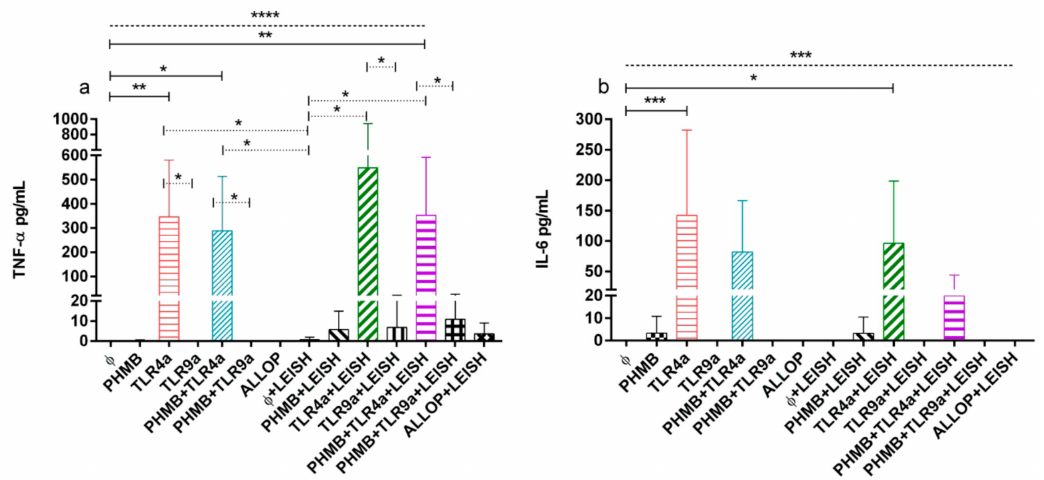
Figure 4. ( a ) TNF- α and ( b ) IL-6 concentrations from uninfected and infected macrophages treated with the following conditions. Medium alone (Ø), Polyhexamethylene biguanide alone (PHMB), MPLA Toll-like receptor agonist 4 (TLR4a), PHMB plus TLR4a (PHMB + TLR4a), CpG ODN Toll-like receptor agonist 9 (TLR9a), PHMB plus TLR9a (PHMB + TLR9a), and allopurinol (ALLOP). All the conditions indicated with LEISH are L. infantum infected replicates. Significant results are described as * 0.05 > p > 0.01, ** 0.01 > p > 0.001, *** 0.001 > p > 0.0001, **** 0.0001 > p. Lines in graphic represent ANOVA (dashed lines), Dunnett´s test (solid lines), and Wilcoxon signed-rank test (dotted